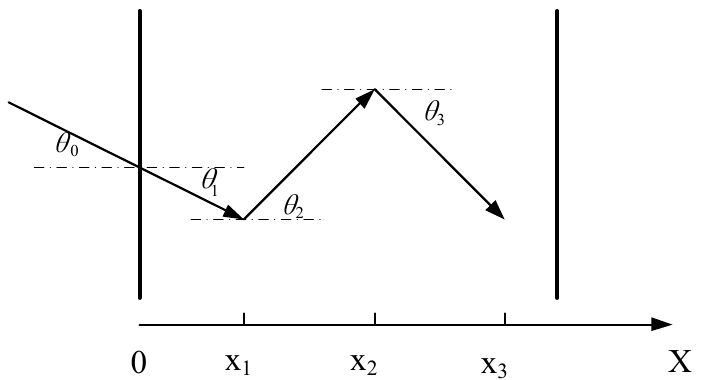
Figure 4. Schematic diagram of the geometric model of electron incidence.